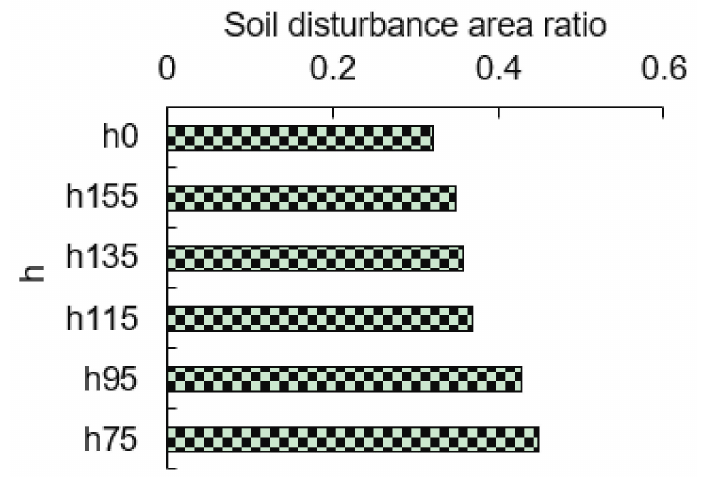
Figure 4. Soil disturbance area ratios with different values of wing mounting height (h). (The h75, h95, h115, h135, and h155 stand for winged subsoiler with h of 75, 95, 115, 135, and 155 mm, respectively, while h0 stands for non-winged